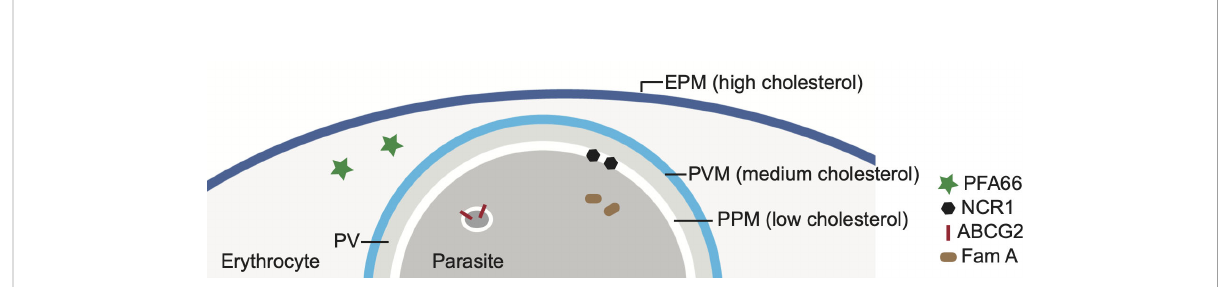
FIGURE 3 Cholesterol gradient in erythrocytes infected with Plasmodium falciparum and localization of several putative cholesterol-binding or transport proteins. The level of cholesterol in each membrane – the erythrocyte plasma membrane (EPM), the parasitophorous membrane (PVM) and the parasite plasma membrane (PPM) – is indicated by the blue coloring. The EPM contains the highest concentration of cholesterol, followed by the PVM and then the PPM. PV-parasitophorous vacuole. Also indicated are the locations of several parasite proteins that are known or have been proposed to have a role in cholesterol transport. See Table 1 for more information about these